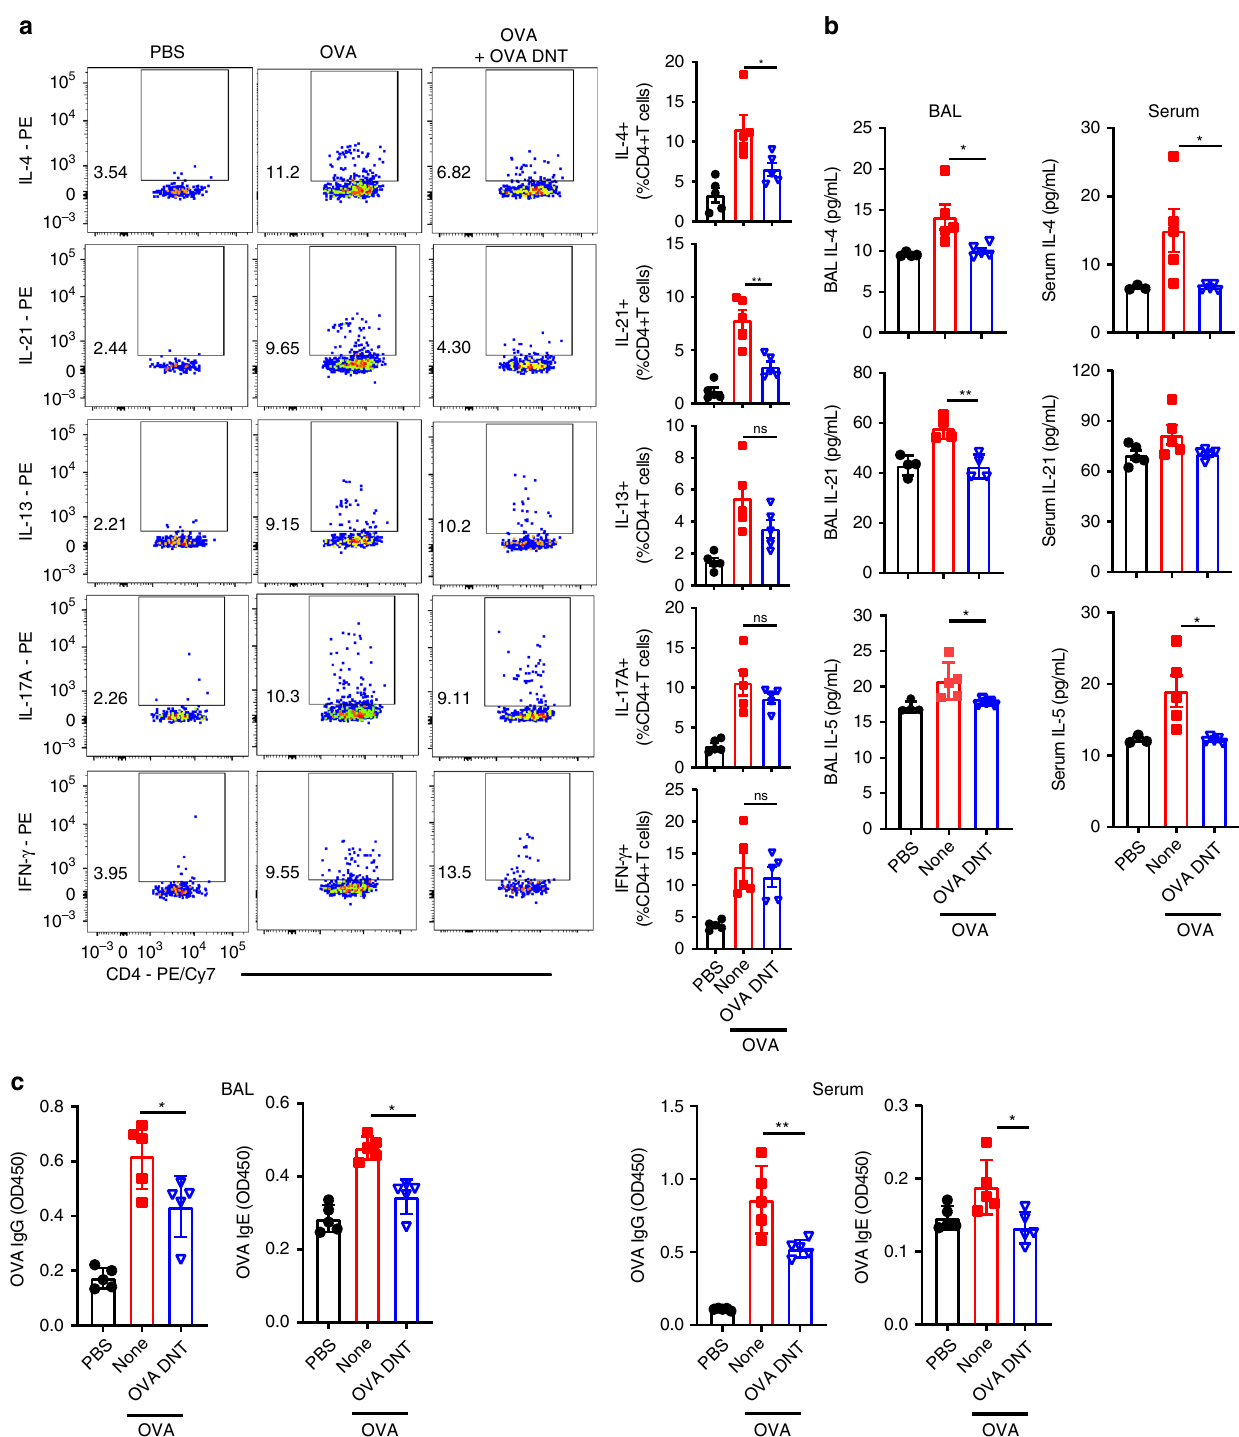
Fig. 3 OVA DNTs suppressed cytokine and OVA-speci fi c Ig production. OVA-sensitized mice were treated with an intravenous transfer of OVA DNTs after the fi rst OVA challenge. The mice were challenged daily for the next two days and sacri fi ced 48 h after the last aerosol challenge. a In fl ammatory cytokine-secreting lung CD4 + T cells were measured by fl ow cytometry. b The BALF and serum cytokine levels were assessed by ELISA. c The levels of OVA-speci fi c BALF and serum IgG/IgE were assessed by ELISA. Data are shown as the mean ± SEM; n = 4 – 5 mice per group. One-way ANOVA was used to calculate signi fi cance. * P < 0.05; ** P < 0.01. Source data are provided as a source data fi